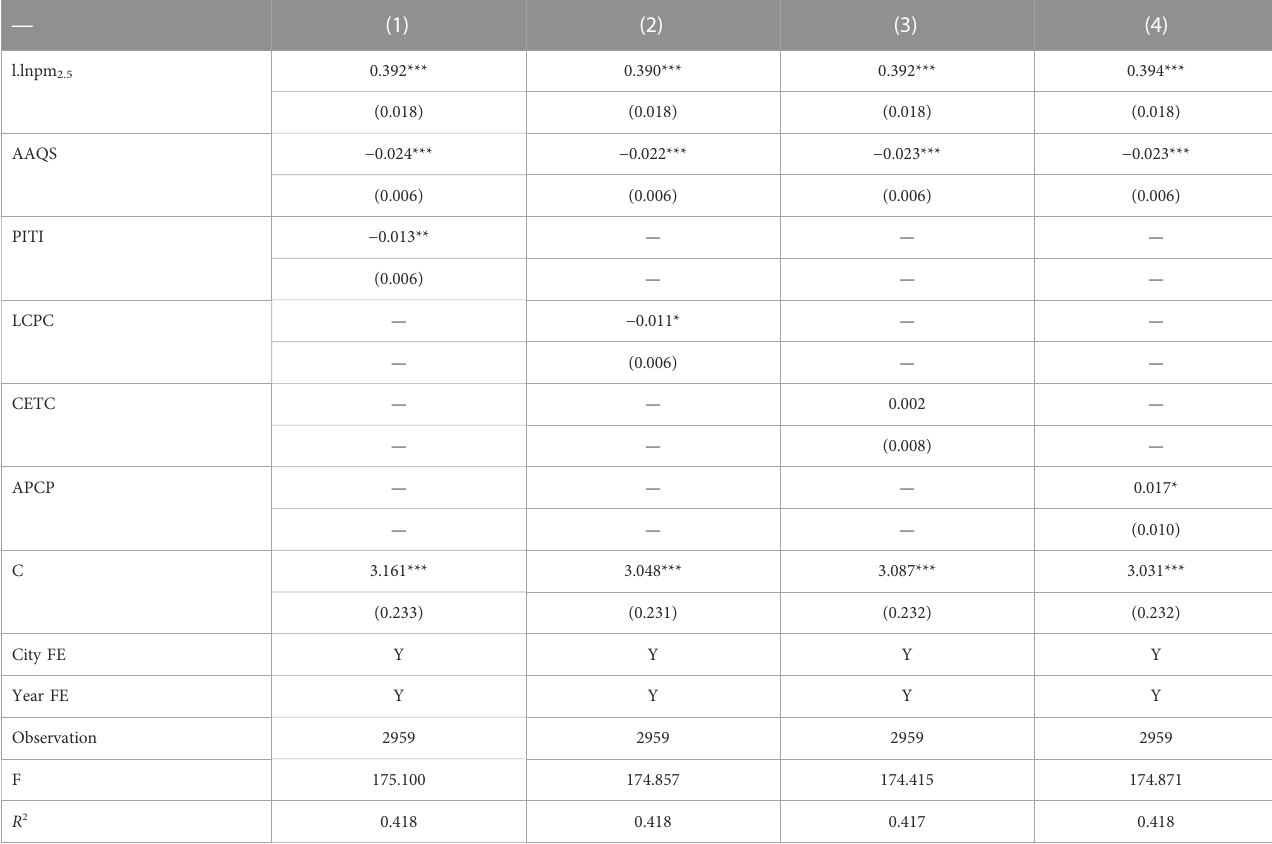
TABLE 9 Re-estimation excluding other policy disturbances.